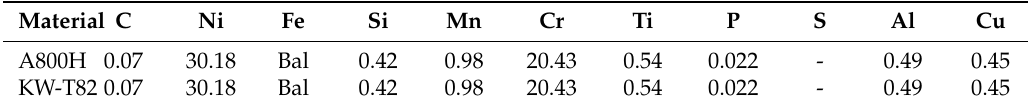
Table 1. The chemical composition of Alloy 800H and its filler metal